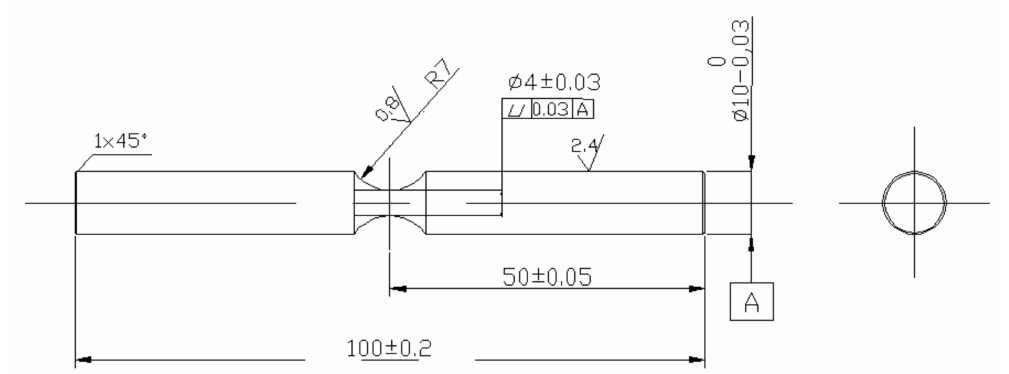
Figure 1. Sketch of the samples indicating shape and size (unit: